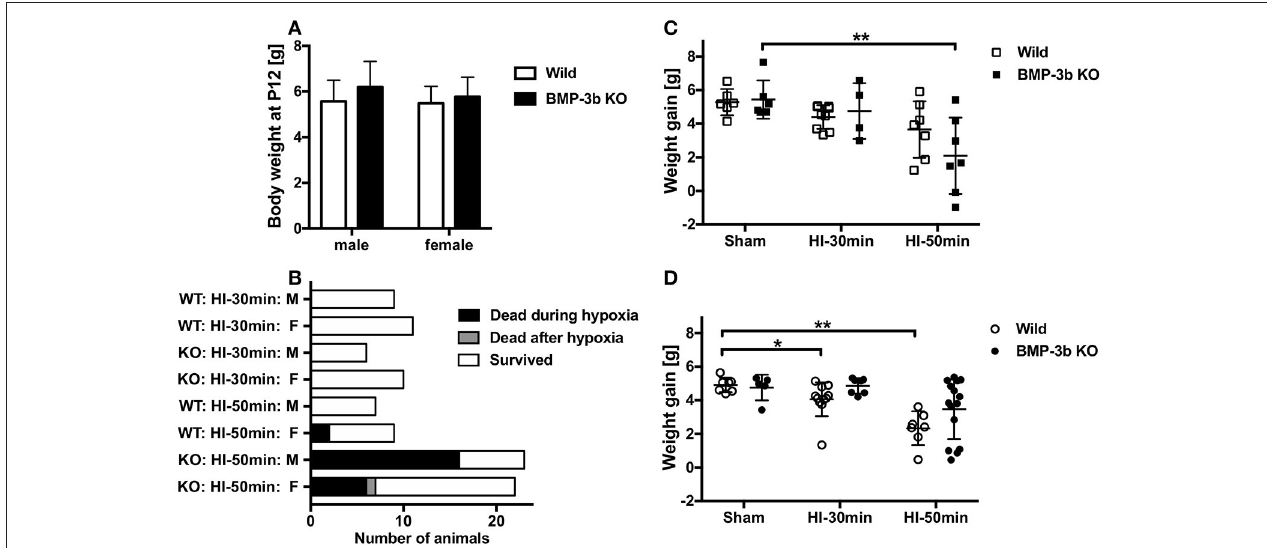
FIGURE 2 | (A) Body weights of mouse pups at the time of surgery (postnatal day 12, P12). Bone morphogenetic protein (BMP)-3b knockout (KO) males, n = 41; BMP-3b KO females, n = 46; wild type males, n = 22; and wild type females, n = 27. Mean ± standard deviation (SD). (B) The numbers of animals dead and survived in each group after the hypoxic-ischemic (HI) insult. One female animal died 6 days after the 50min HI insult. (C) Body weight gain in male pups during the observation period from P12 to P26. (D) Body weight gain in female pups during the observation period. Sham, sham-surgery controls; HI-30min, hypoxia-ischemia for 30min; HI-50min, hypoxia-ischemia for 50min. * p < 0.05, ** p < 0.01.